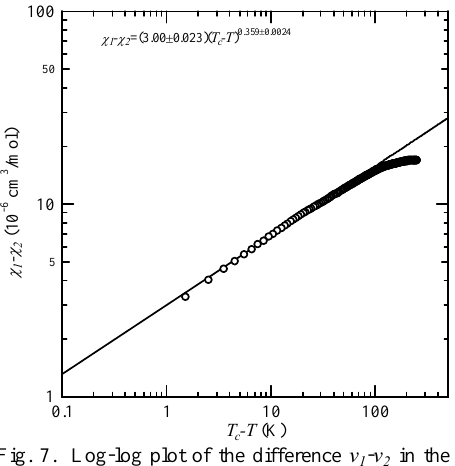
Fig. 6. Log-log plot of the difference v 1 - v 2 in the sound velocity along the phase boundary.